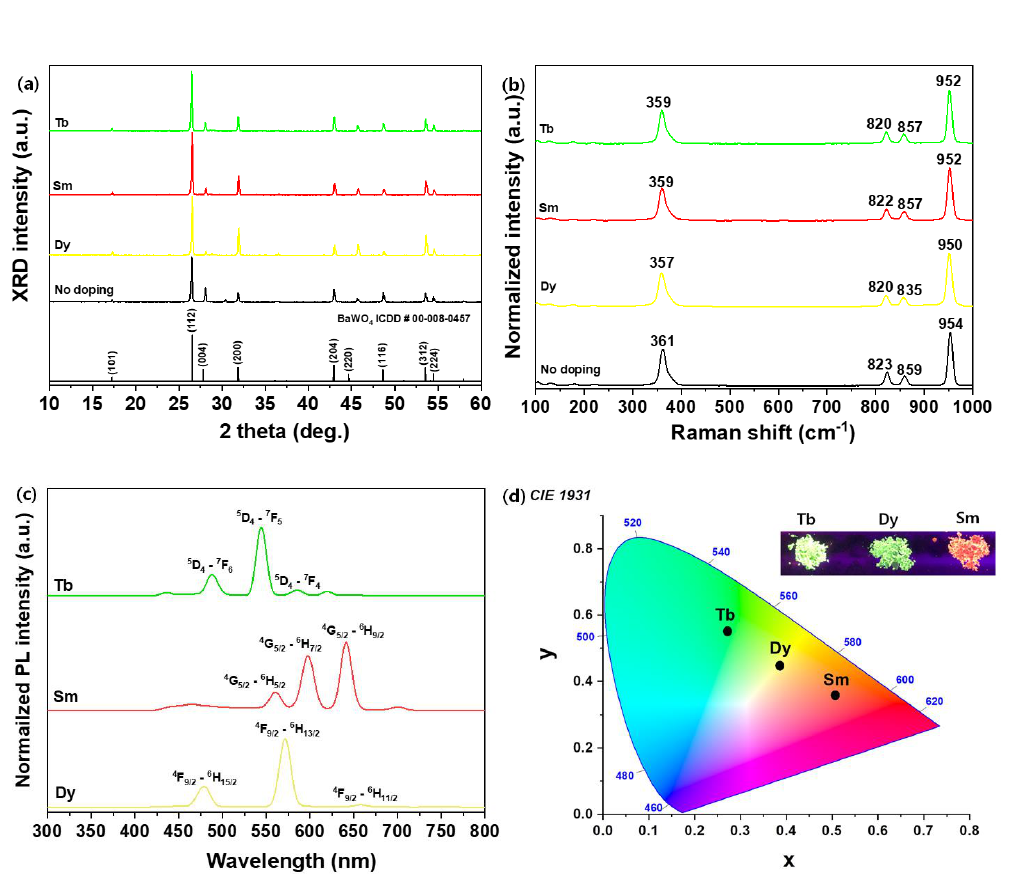
Figure 5. BaWO 4 phosphors doped with different activator ions (Dy 3+ , Sm 3+ , Tb 3+ ): ( a ) XRD patterns, ( b ) Raman spectra under a 633 nm laser, ( c ) photoluminescence spectra at 325 nm, ( d ) International Commission on Illumination (CIE) coordinates and inset phosphor pictures under a UV lamp.